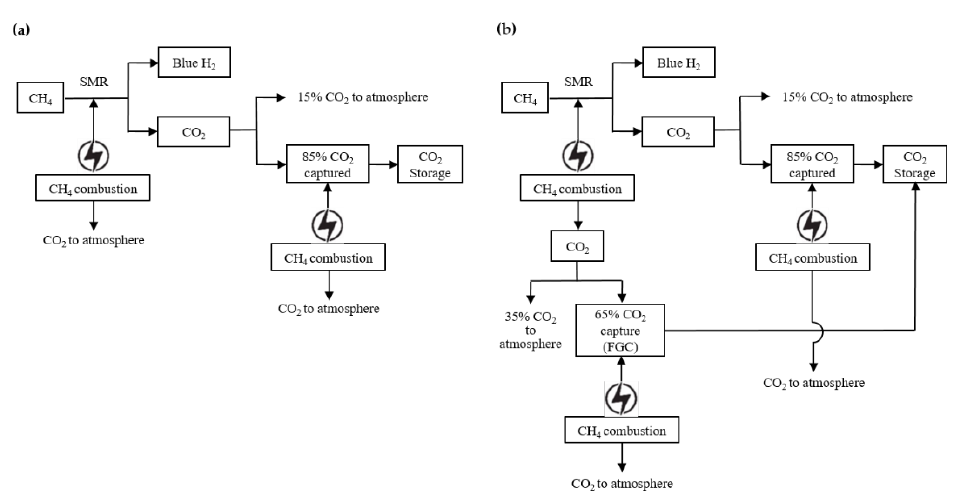
Figure 2. PFD of ( a ) blue hydrogen and ( b ) blue hydrogen with